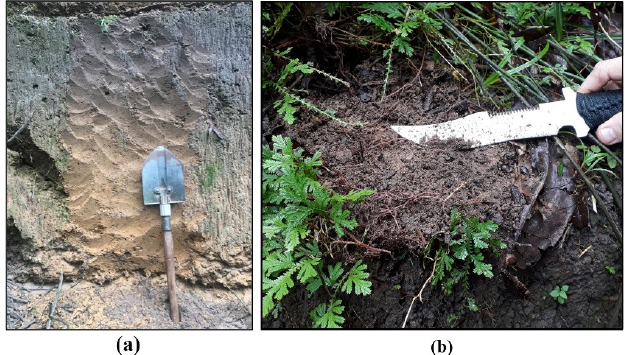
Figure 1. Yellow Latosol profile ( a ) and the surface horizon used in the incubation test ( b